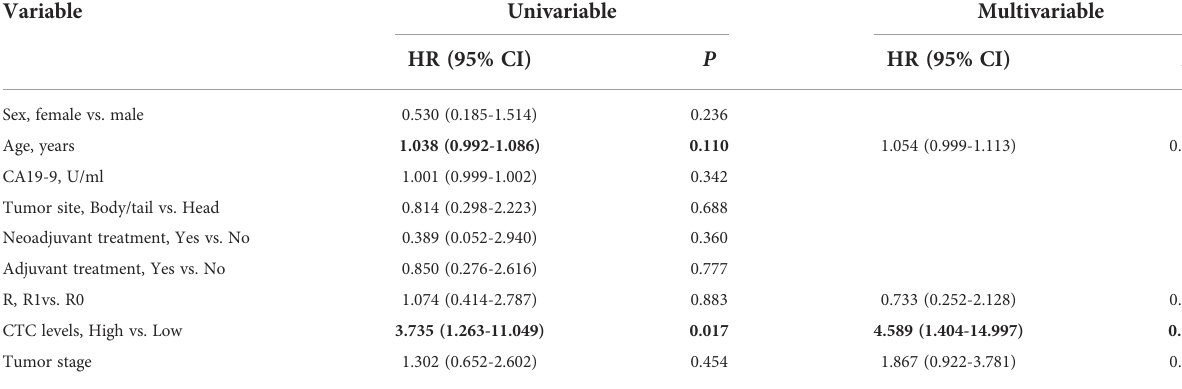
TABLE 3 Uni- and multivariable analyses of prognostic factors of DFS for patients in the surgical group.